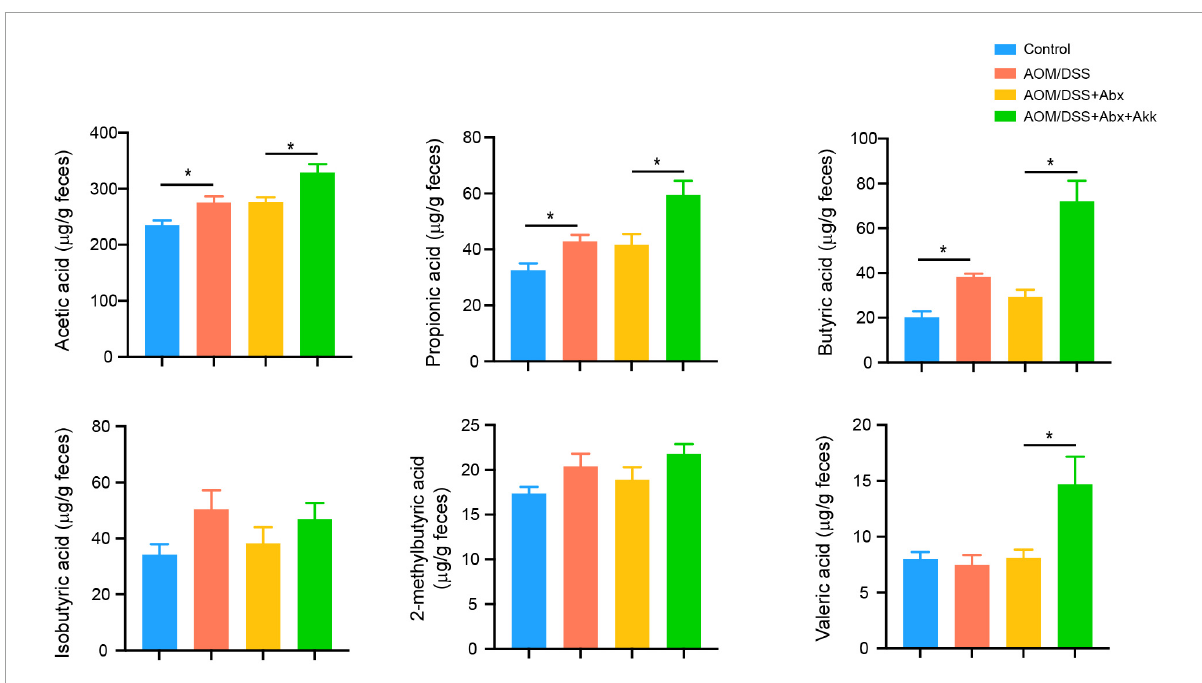
FIGURE8 Akkermansia muciniphila administration impacted the metabolism of SCFAs in the development of CAC. Fecal SCFA levels (acetic acid, propionic acid, butyric acid, isobutyric acid, 2-methylbutyric acid, and valeric acid) in the four groups (week 12). Data are shown as means ± SEM. * P <